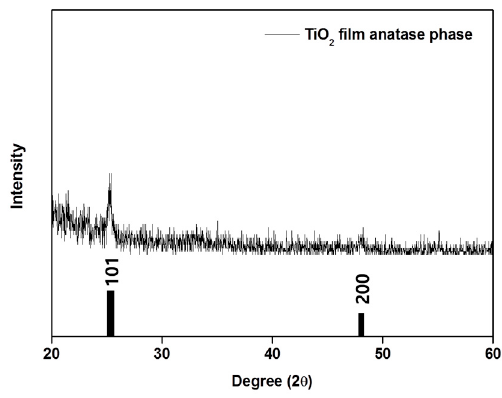
Figure 3. XRD pattern of the 400 nm size PS-patterned TiO 2 film.